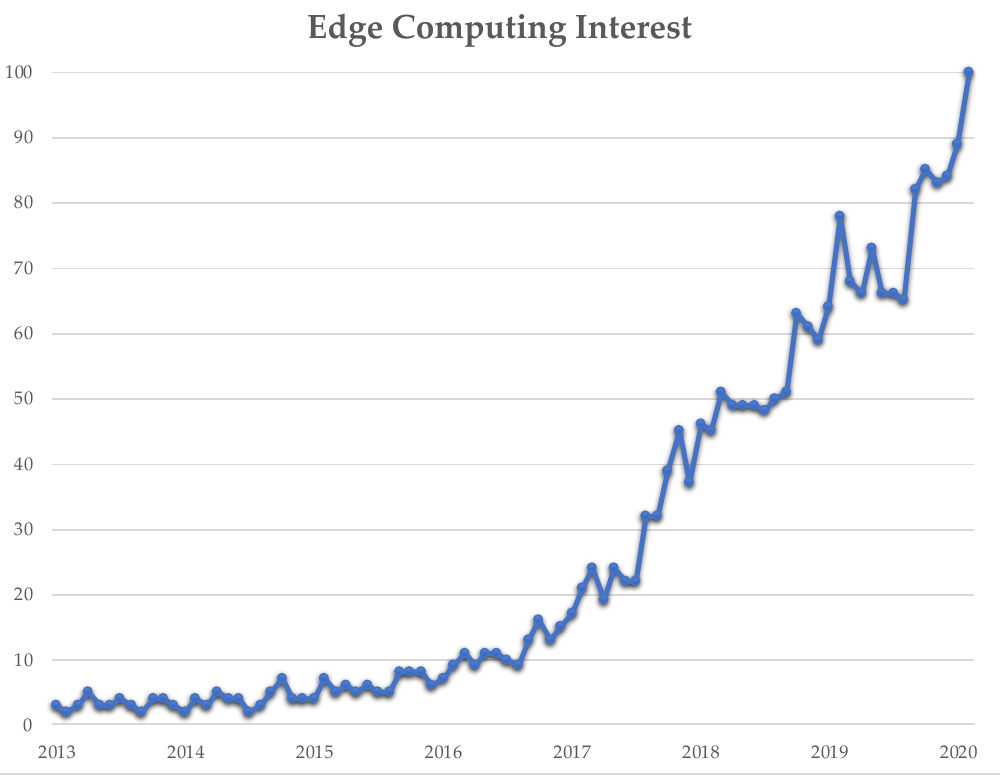
Figure 1. Edge computing interest (Google